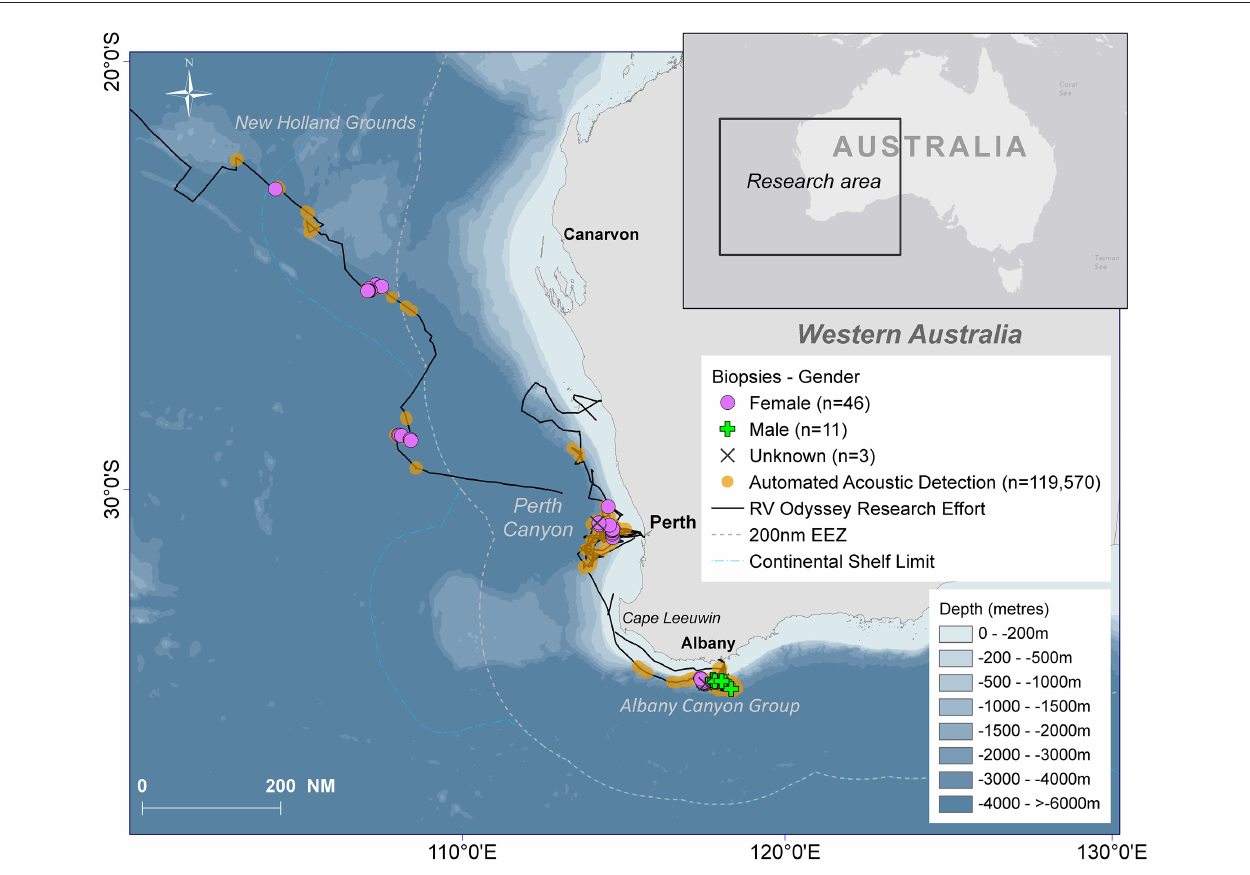
FIGURE 3 | The south-eastern Indian Ocean study area with the track of the RV Odyssey, locations of the biopsy samples and gender of the sampled sperm whales, all automated acoustic detections of sperm whales recorded by Rainbow Click and bathymetry.